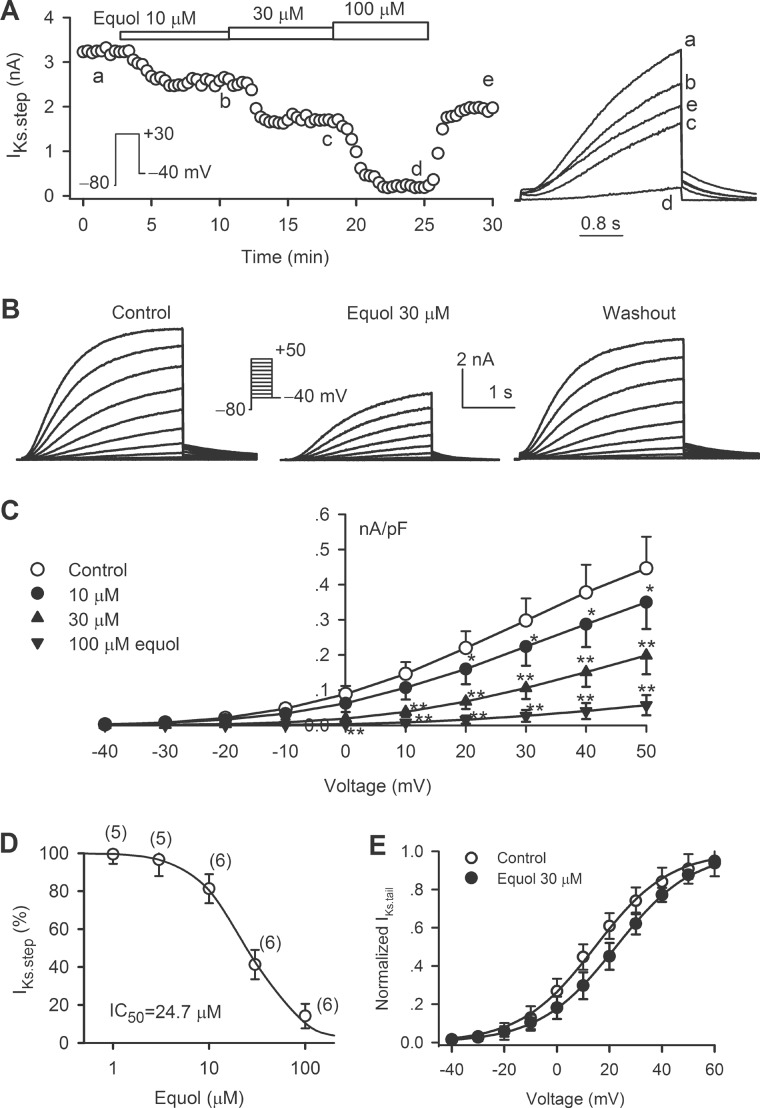
Effect of equol on recombinant IKs.(A) Time course of IKs.step recorded in a representative HEK 293 cell stably expressing hKCNQ1/hKCNE1 with the voltage protocol shown in the inset in the absence and presence of 10, 30, and 100 μM equol. Original current traces at corresponding time points are shown in the right. (B) Voltage-dependent IKs traces recorded in a typical experiment with the voltage protocol shown in the inset in the absence and presence of 30 μM equol and upon washout. (C) I-V relationships of IKs.step in the absence and presence of 10, 30 and 100 μM equol (n = 6, *P<0.05, **P<0.01 vs. control). (D) Concentration-response relationship of IKs.step inhibition by equol at +50 mV was fitted to the Hill equation. The numbers in the parentheses represent experimental number. (E) Variables of normalized IKs.tail were fitted to the Boltzmann equation in the absence and presence of 30 μM equol.